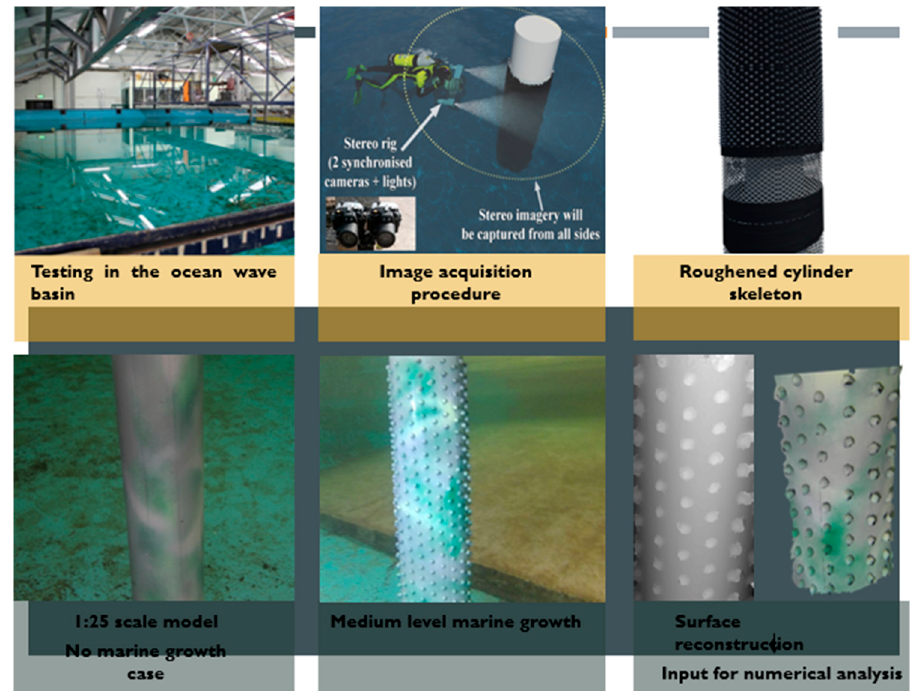
Figure 20. TRL testing for biofouling.